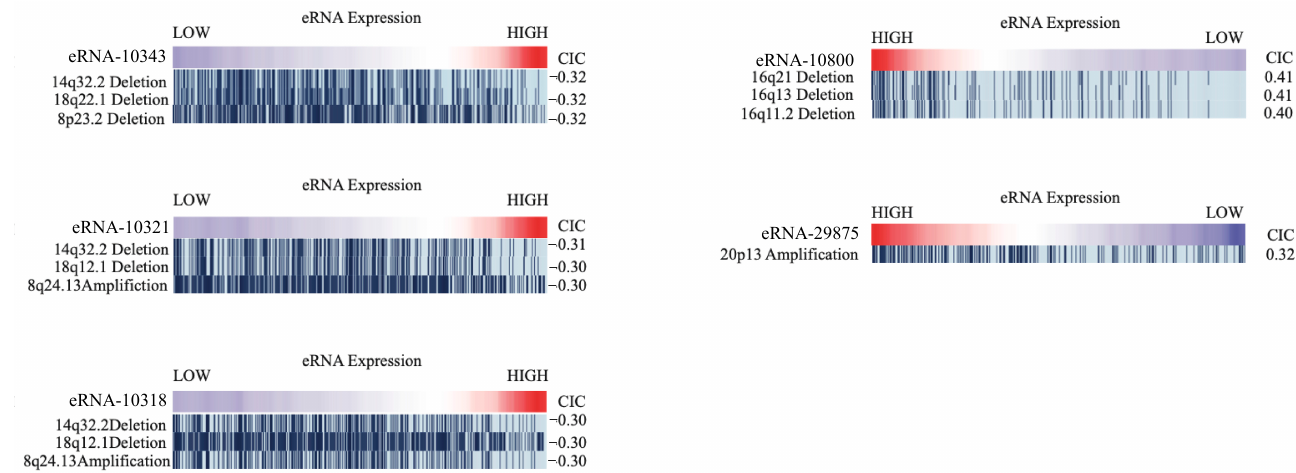
Figure 7. Association between genomic alterations and the expression of eRNAs in HNSCC using Repeated Evaluation of Variables conditionAL Entropy and Redundancy (REVEALER) (CIC > 0.3 and p < 0.05).